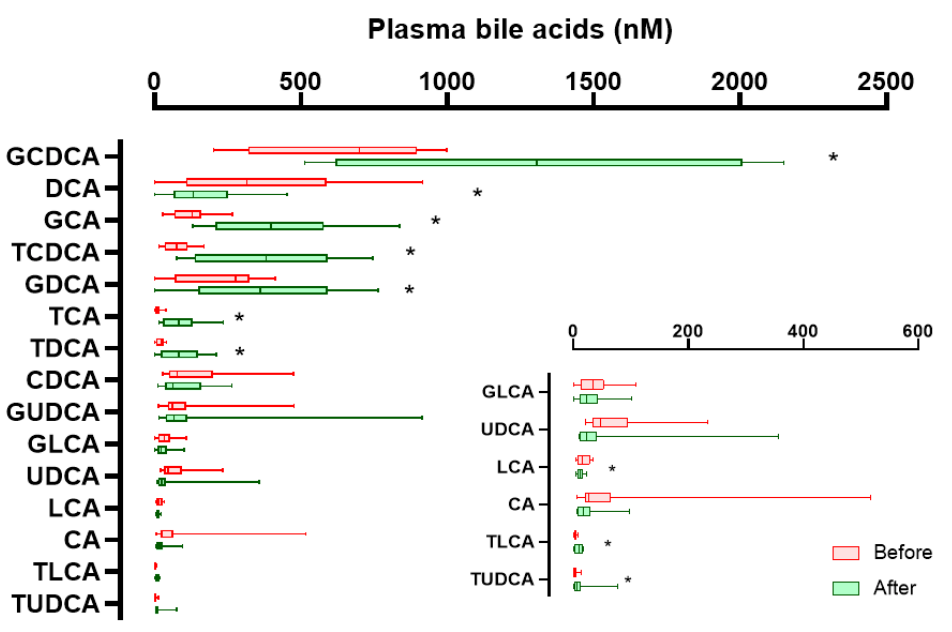
Figure 2. YH1 altered plasma bile acid profiles in men with type 2 diabetes and hyperlipidemia. The concentration of each bile acid in the plasma of ten patients before (red) and after (green) YH1 treatment is represented by a box-and-whisker plot. The line inside the box represents the median value, and the box is between the first and third quartiles. The ends of the whiskers represent the minimum and maximum values. Wilcoxon signed-rank test was used, and * p < 0.05 was considered statistically significant.